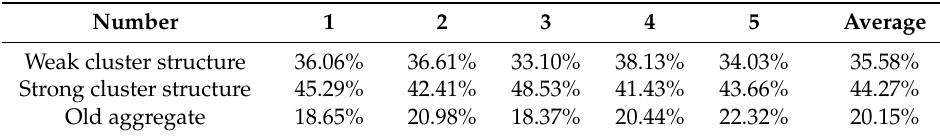
Table 2. The Proportion of Three Kinds of Structures (16–19 mm).